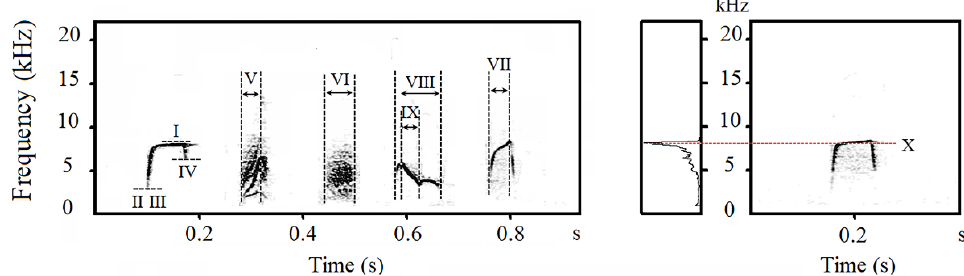
Figure 1. A sound spectrogram and spectra illustrating measurements of note acoustic parameters. Vertical lines indicate approximate boundaries for acoustic parameters. I: Maximum Frequency; II: Minimum Frequency; III: Start Frequency; IV: End Frequency; V: Ascending Duration; VI: Total Duration; VII: Maximum Frequency Duration; VIII: Minimum Frequency Duration; IX: Descending Duration; X: Peak Frequency.